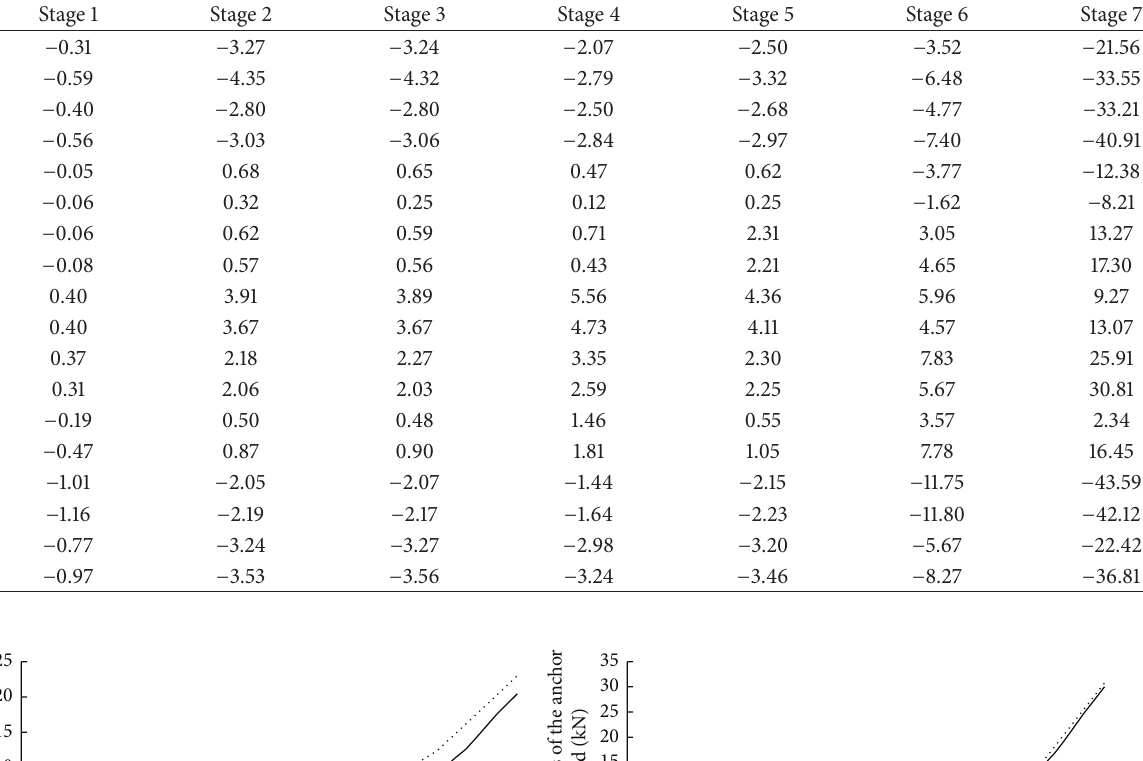
Table 1: Test results of Group M-A (unit: kN).